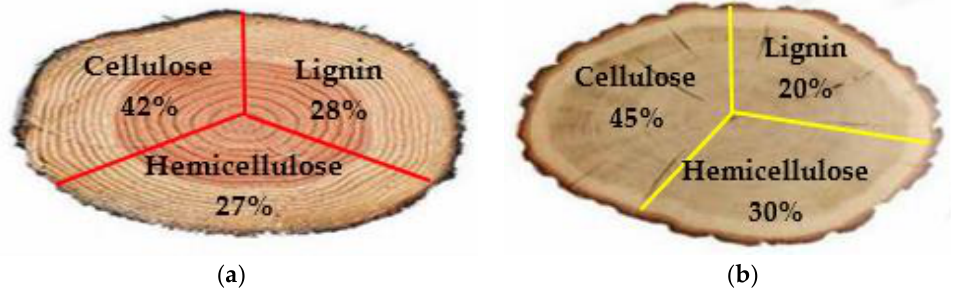
Figure 7. Percentage contents of main constitute of woody biomass in a wood cell. ( a ) Softwood; ( b ) Hardwood (adapted from [72]).